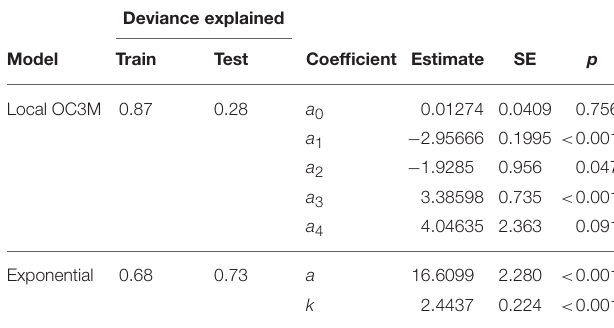
TABLE 7 | Summary of results of the two locally-tuned models for Tasman Bay trained on closest-time data. Deviance explained Model